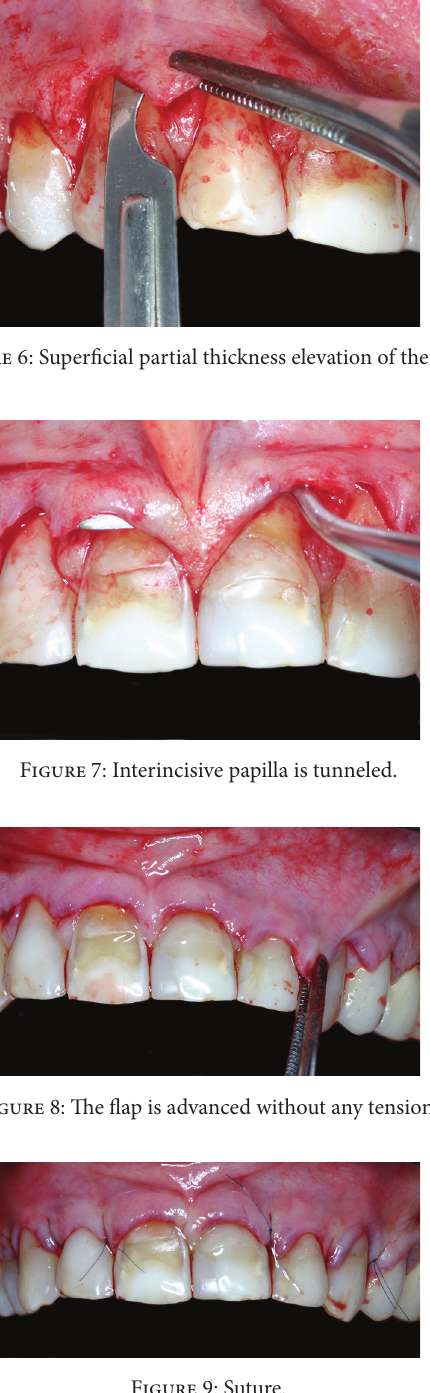
Figure 9: Suture.